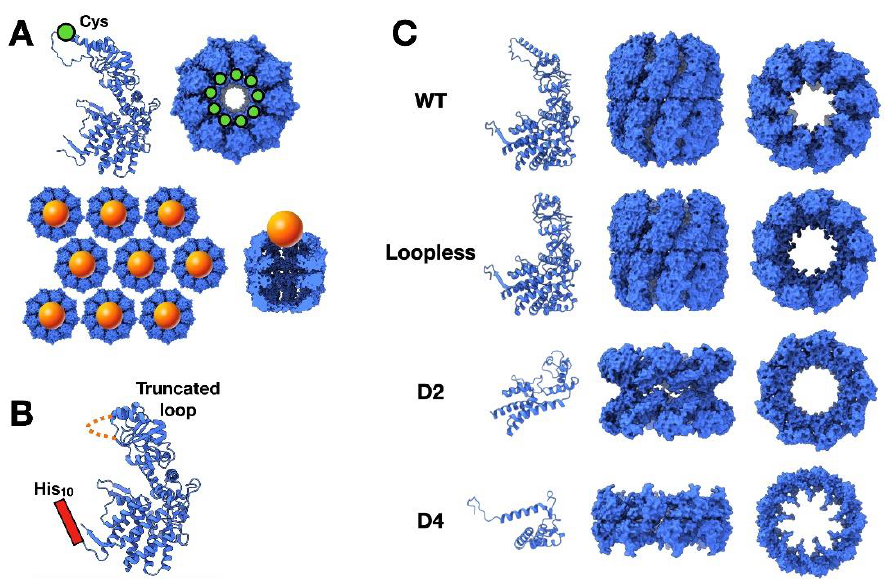
Figure 6. High-order Type II chaperonins for nanotechnological purposes. ( A ) Top, scheme of the mutation carried out in the Sulfolobus shibatae thermosome, in which a Cys residue is introduced at the tip of the helical protrusion. Bottom, conditions found for the generation of two-dimensional, ordered arrays [47]. ( B ) A version of the prior scheme, in which the same authors replaced the helical protrusion with a His tag in the interior of the cavity, thus allowing a wider access [48]. ( C ) Representations of some of the different mutants generated by [49]. Left, atomic model of the different variants. Centre and right, two orthogonal views of the oligomer formed with the different variants.